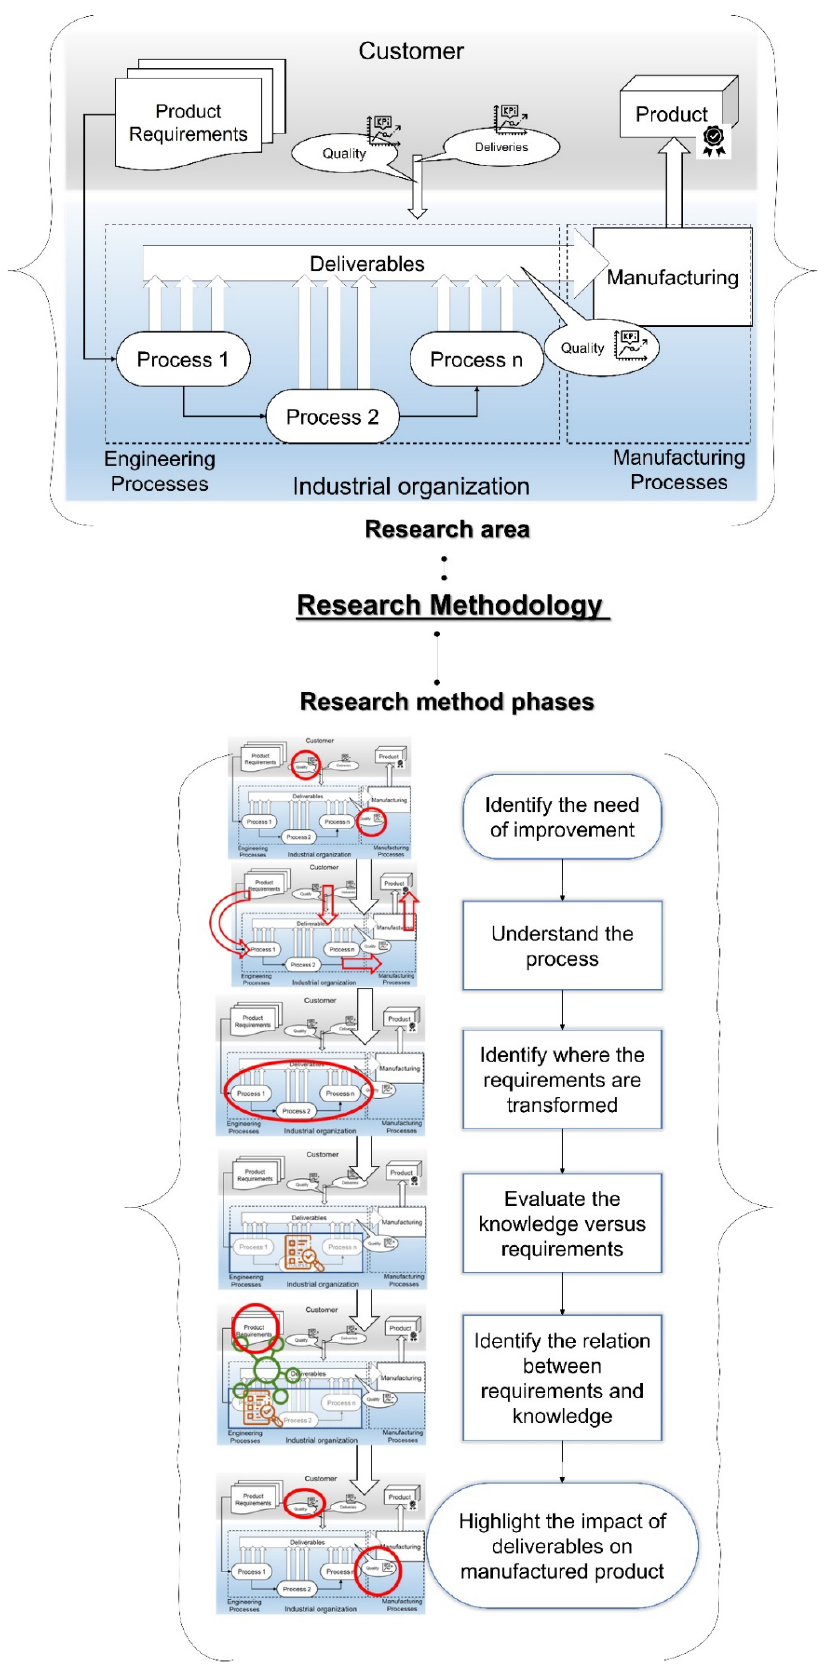
Figure 2. Research design.